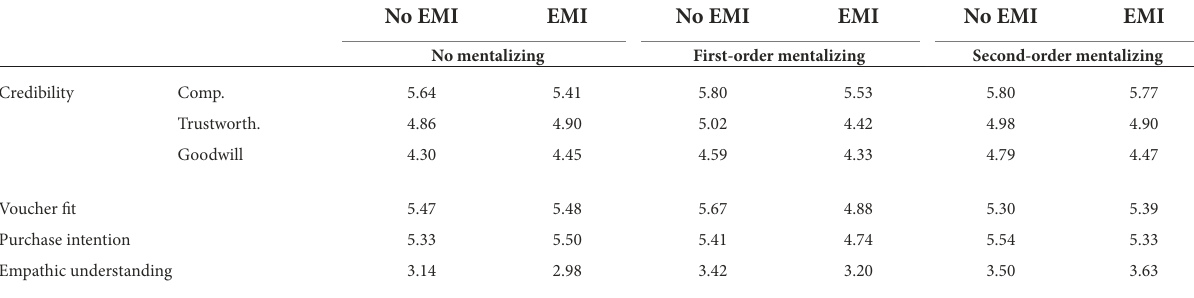
TABLE 3 Summary of the mean values for the metric, dependent measures.